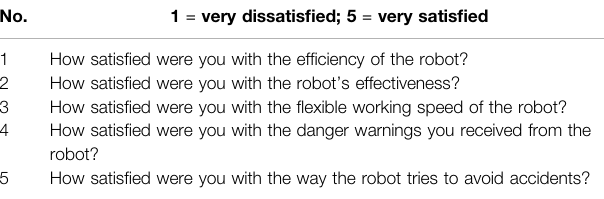
TABLE 4 | The items measuring the satisfaction regarding the collaboration with the robot arm. For each statement, please consider to what extent you think it is